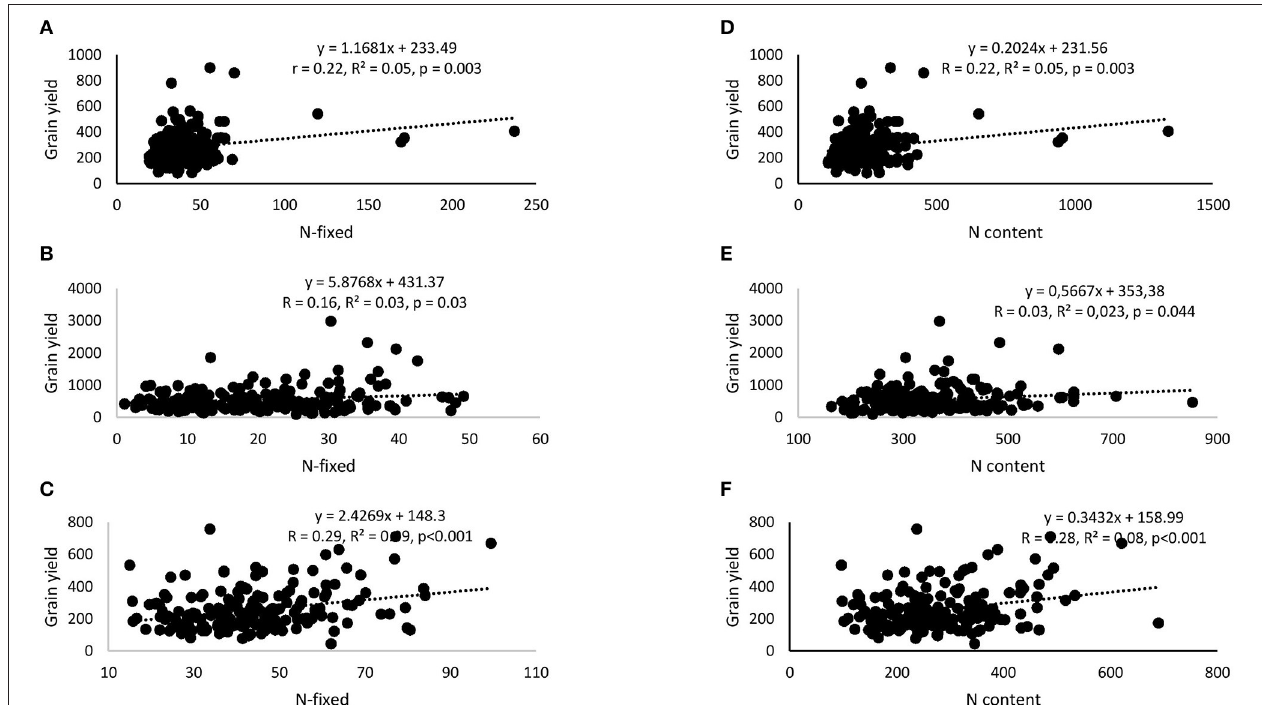
FIGURE 6 | Correlation and regression analysis between N-fixed and grain yield of 15 cowpea genotypes planted in (A) Nyankpala, (B) Savelugu, and (C) Gbalahi, and between shoot N content and grain yield in (D) Nyankpala, (E) Savelugu, and (F)